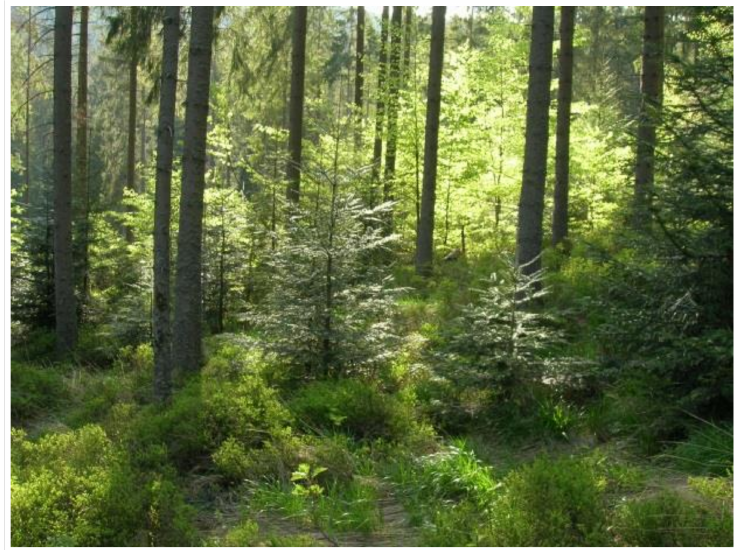
Figure 5. A forest managed using the shelterwood cutting system, showing the natural regeneration of different tree species under the overstory layer (photo: Z.